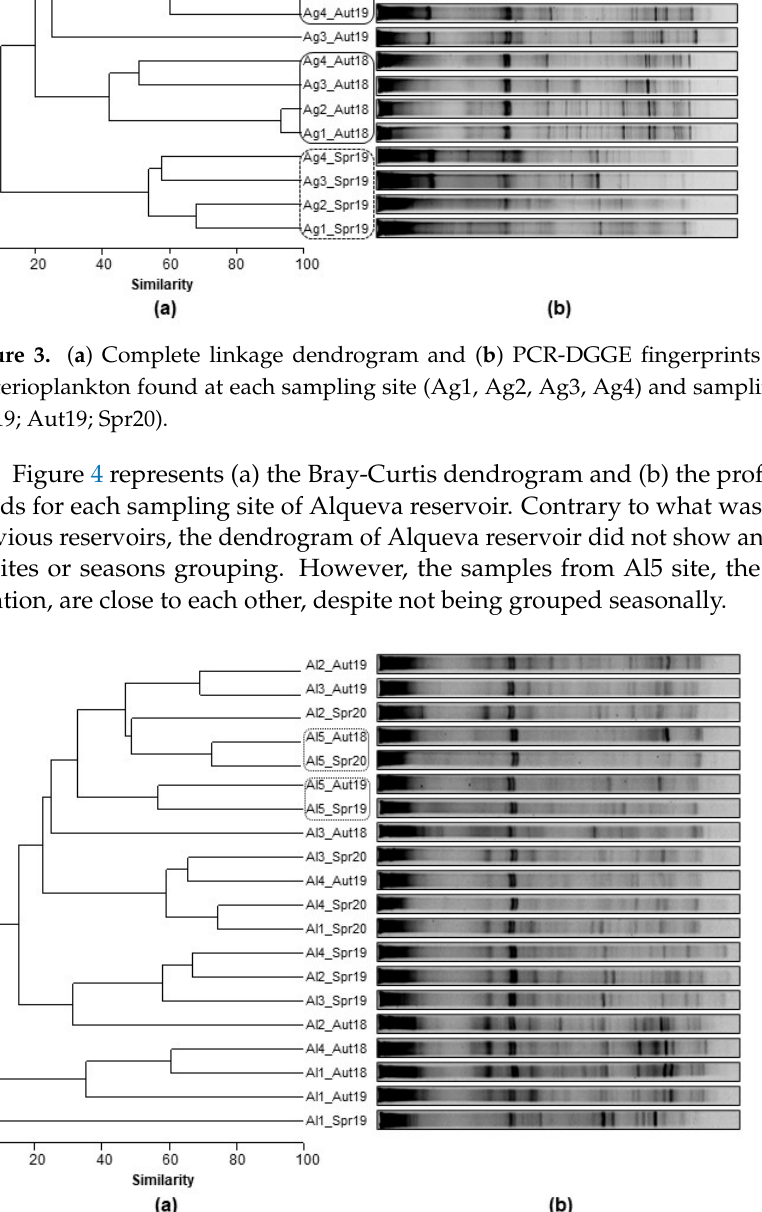
9 of 17 Figure 2. ( a ) Complete linkage dendrogram and ( b ) PCR-DGGE fingerprints of the bacterioplankton